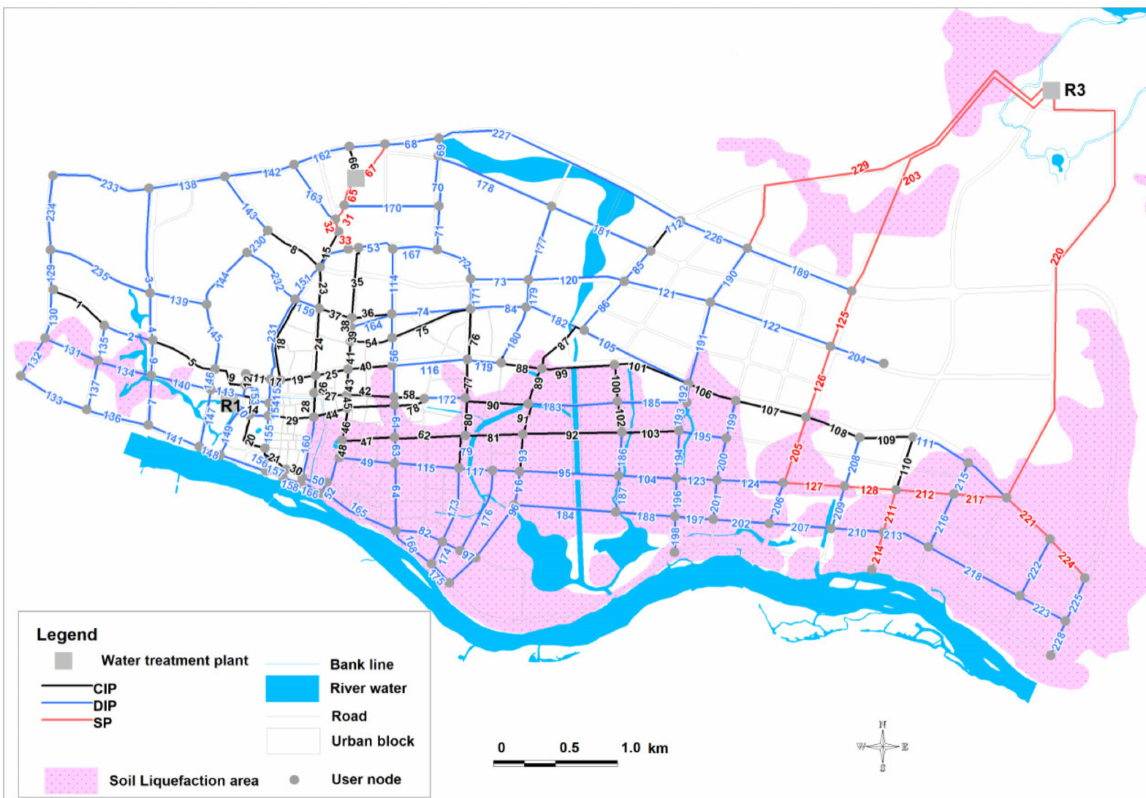
Figure 7. Layout of the WDS in Z